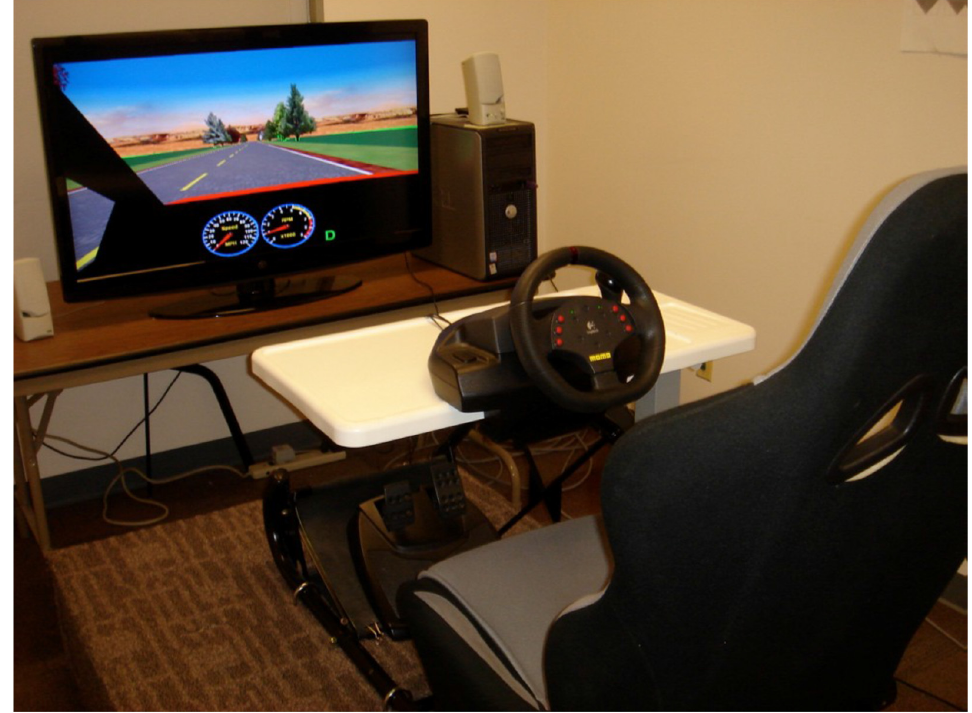
Figure 1. STISIM Model 400 simulator used in study.